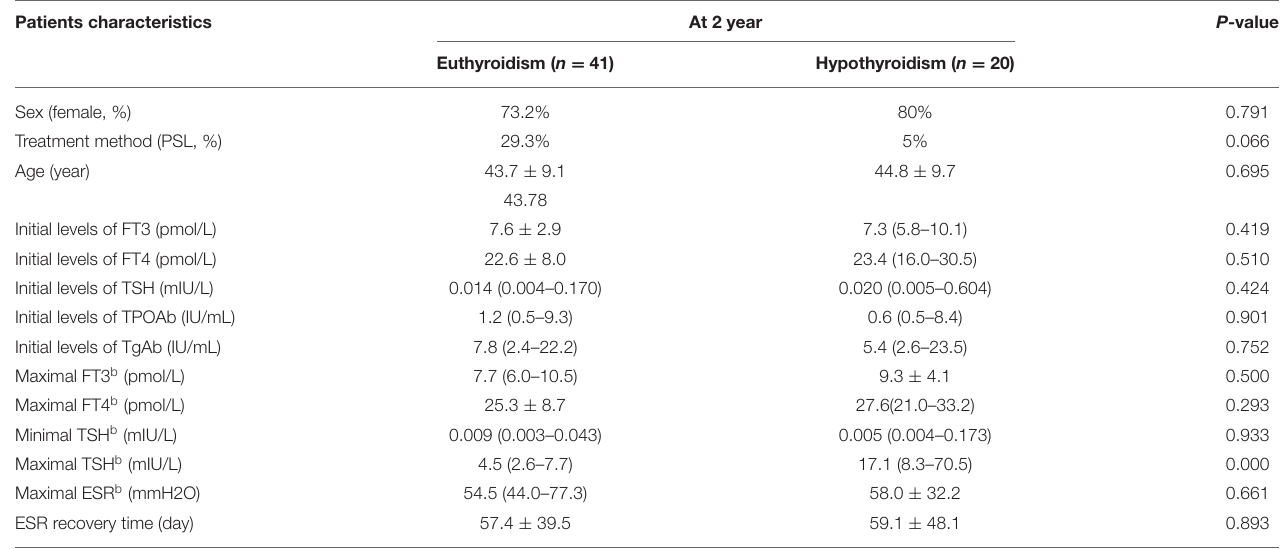
TABLE 4A | Patient characteristics. Patients characteristics